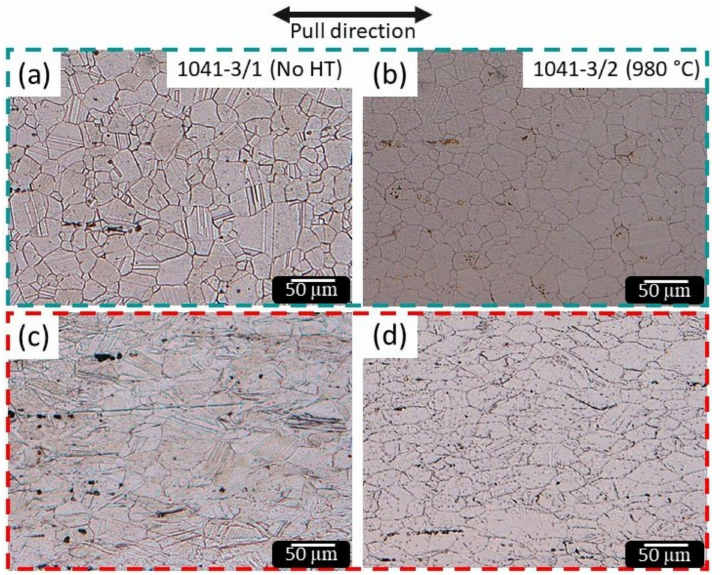
Figure 6. The etched microstructure on fractured sample 1041-3. ( a , c ) show pre-heat treatment and ( b , d ) show post-heat treatment microstructures in the undeformed and deformed areas.